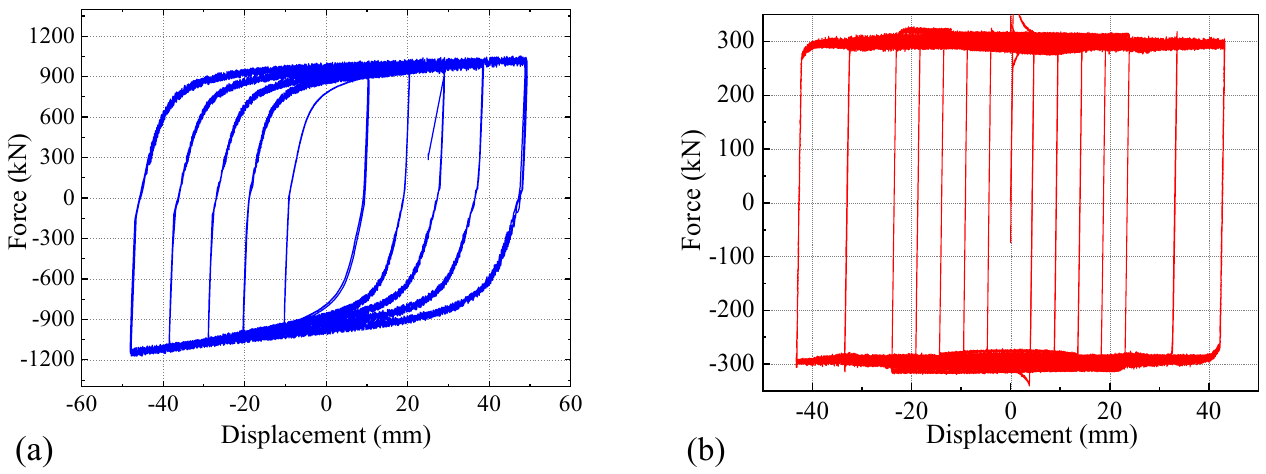
Figure 10. Hysteretic responses for the tested specimens: ( a ) FBRB; and ( b ) the friction element (FE). The hysteretic response of the FE specimen is shown in Figure 10b. Note that the FE specimen consists of the BRB steel‑tube casing and FDs in series connection. In other